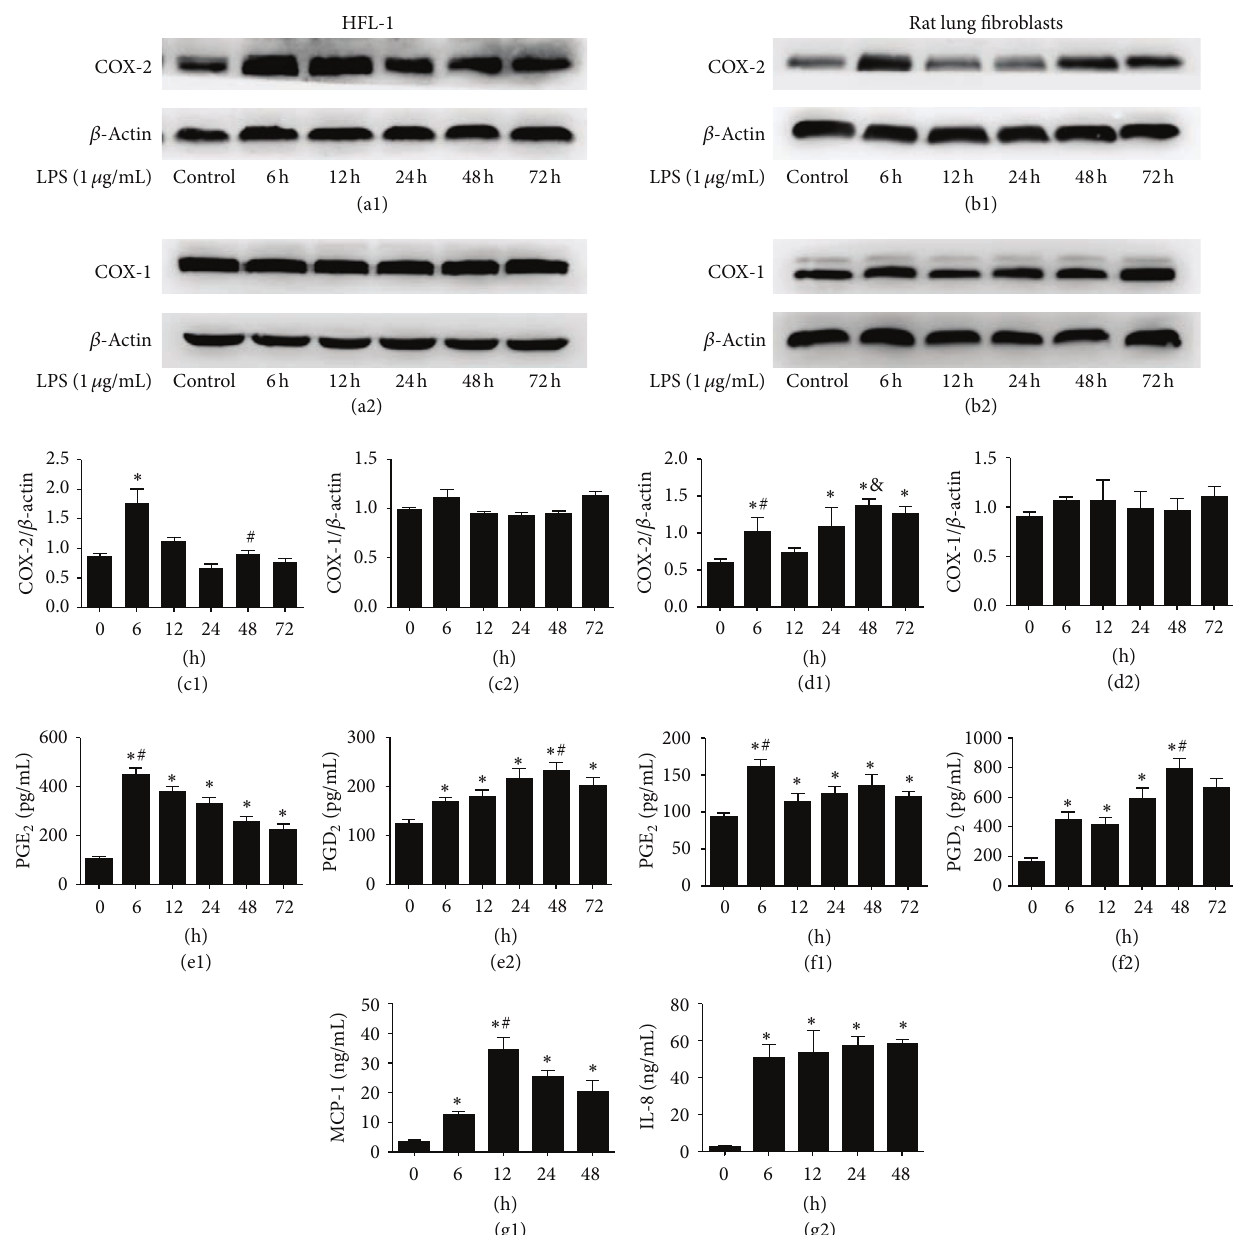
Figure 1: The effect of LPS on COX-1, COX-2, PGE 2, PGD 2 , MCP-1, and IL-8 expression in lung fibroblasts. ((a1), (a2), (c1), (c2)) HFL-1 cells were incubated with LPS (1 𝜇 g/mL) for 6, 12, 24, 48, and 72 hours. The expression of COX-1 and COX-2 protein was assessed by western blot and analysed by densitometry compared to 𝛽 -actin expression. The expression of COX-2 protein in HFL-1 cell line was increased and peaked both at 6 hours and 48 hours after LPS stimulation ( ∗ 𝑃 < 0.05 versus control, 12, 24, 48, and 72 hours groups, # 𝑃 < 0.05 versus 24 hours group). However, no significant change in the protein expression of COX-1 was observed after treatment with LPS in HFL-1 cell line. ((e1), (e2)) Supernatants were collected after LPS (1 𝜇 g/mL) treatment for 6, 12, 24, 48, and 72 hours. PGE 2 protein was measured by ELISA. Data are expressed as mean ± SE for each group ( ∗ 𝑃 < 0.05 versus control, # 𝑃 < 0.05 versus 12, 24, 48, and 72 hours groups). PGD 2 protein was also assayed by ELISA. Data are expressed as mean ± SE for each group ( ∗ 𝑃 < 0.05 versus control, # 𝑃 < 0.05 versus 6, 12, 72 hours groups). ((b1), (b2), (d1), (d2), (f1), (f2)) We also dulicated our test in primary rat lung fibroblasts ((b1), (d1)), ( ∗ 𝑃 < 0.05 versus control, # 𝑃 < 0.05 versus 12 hour group, & 𝑃 < 0.05 versus 6, 12, 24, and 72 hours groups). ((b2), (d2)) No significant change in the protein expression of COX-1 was observed after treatment with LPS in primary rat lung fibroblasts ( ∗ 𝑃 < 0.05 versus control, # 𝑃 < 0.05 versus 12, 24, 72 hours groups, (f1)) and ( ∗ 𝑃 < 0.05 versus control, # 𝑃 < 0.05 versus 6, 12, 24, 72 hours group, (f2)). All experiments were repeated in triplicate. ((g1), (g2)) Supernatants were collected after LPS (1 𝜇 g/mL) treatment for 0, 6, 12, 24, and 48 hours in primary rat lung fibroblasts. MCP-1 protein was measured by ELISA. Data are expressed as mean ± SE for each group ( ∗ 𝑃 < 0.05 versus control, # 𝑃 < 0.05 versus 6, 24, 48 hours groups). IL-8 protein was also assayed by ELISA. Data are expressed as mean ± SE for each group ( ∗ 𝑃 < 0.05 versus